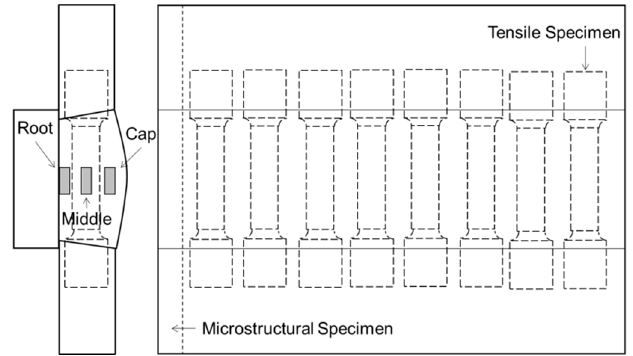
Figure 3. The sampling positions of microstructural observations and tensile tests.